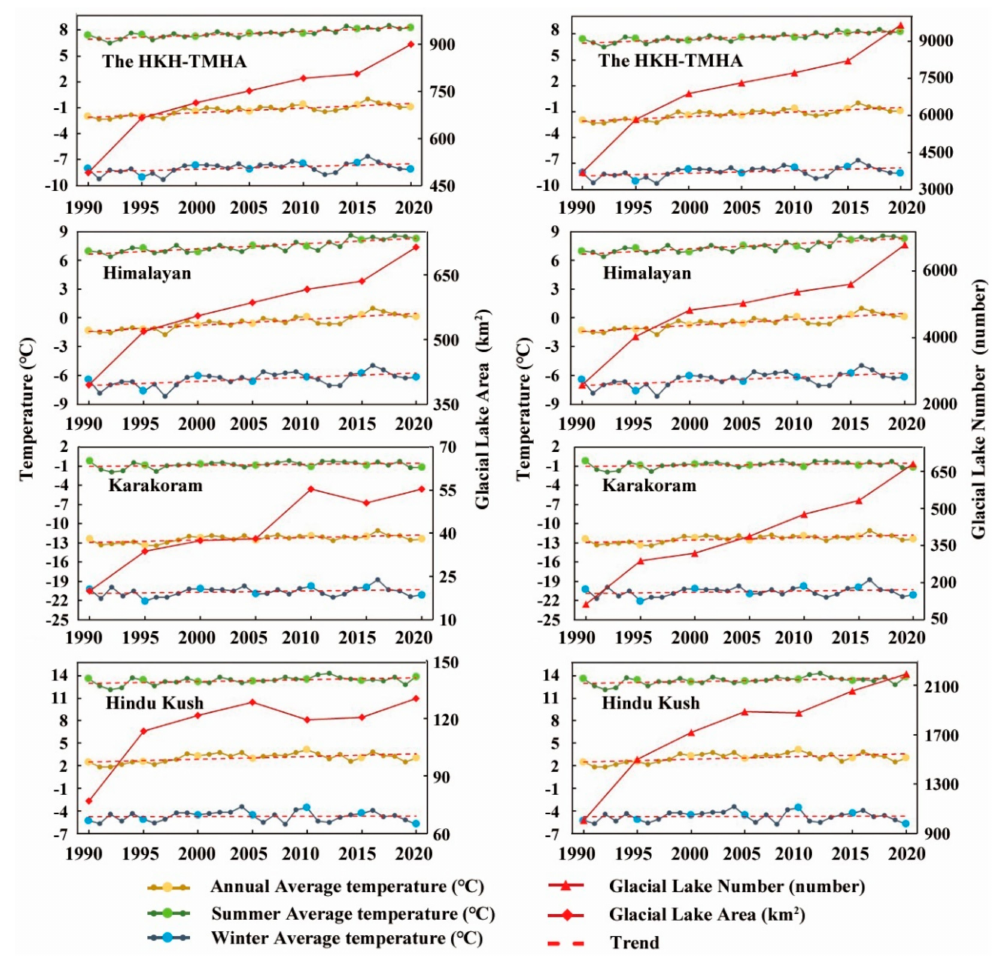
Figure 17. Time series of daily average